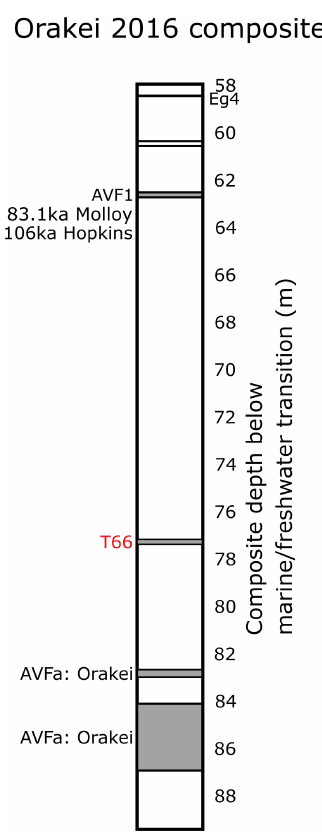
Figure A3. Lower section of the Orakei 2016 composite sequence highlighting the position of the T66 layer between the stratigraphi- cally matched position of the AVF1 horizon and the primary erup- tive material from the Orakei volcanic centre correlated to tephra layer AVFa by Hopkins et al.